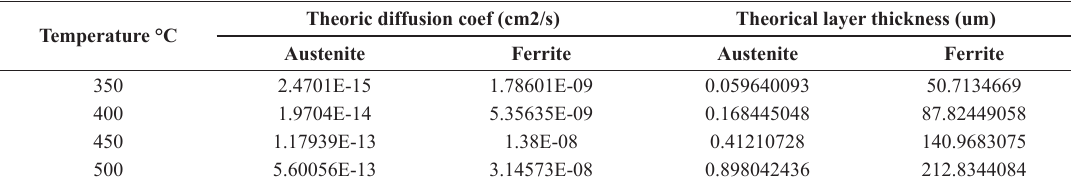
Table 3. Theorical values of diffusion coeffients and layer thickness for each phase and temperature